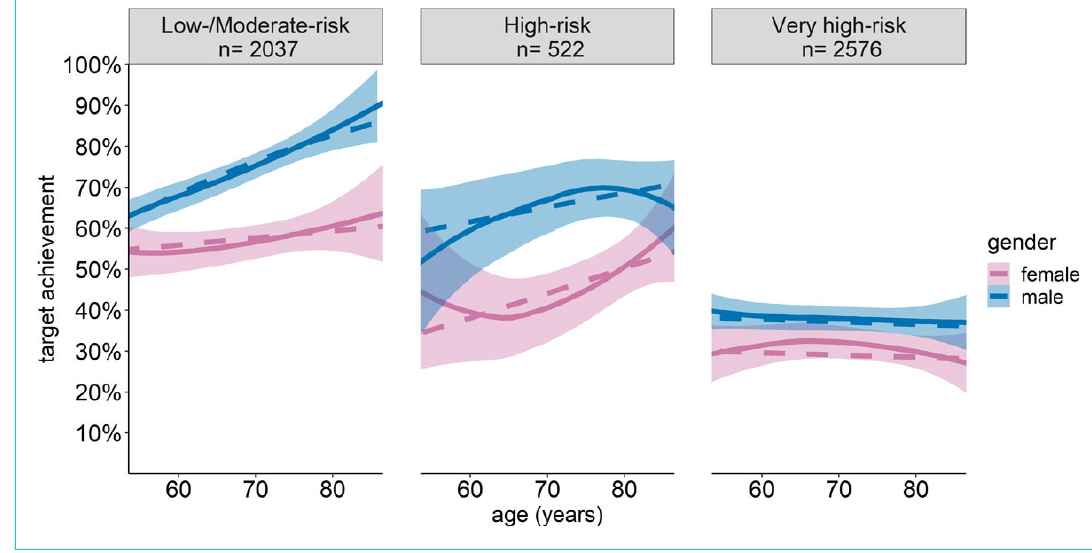
Figure 3: LDL target achievement by cardiovascular risk, age and gender. Target achievement plotted with respect to patient age, stratified by CV risk category and gender. Solid lines and CI represent empirical data, while dashed lines represent the predicted values based on the re- gression analysis. Data visualisation was restricted to ages 55–85 years due to limited sample sizes at the tails of the